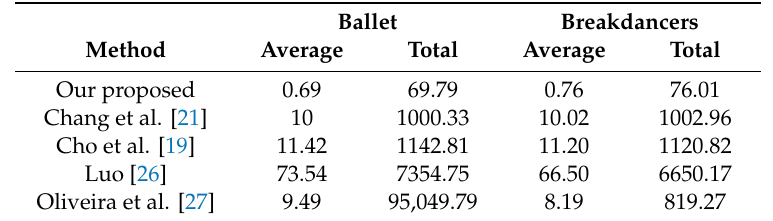
Table 2. Execution time in seconds.